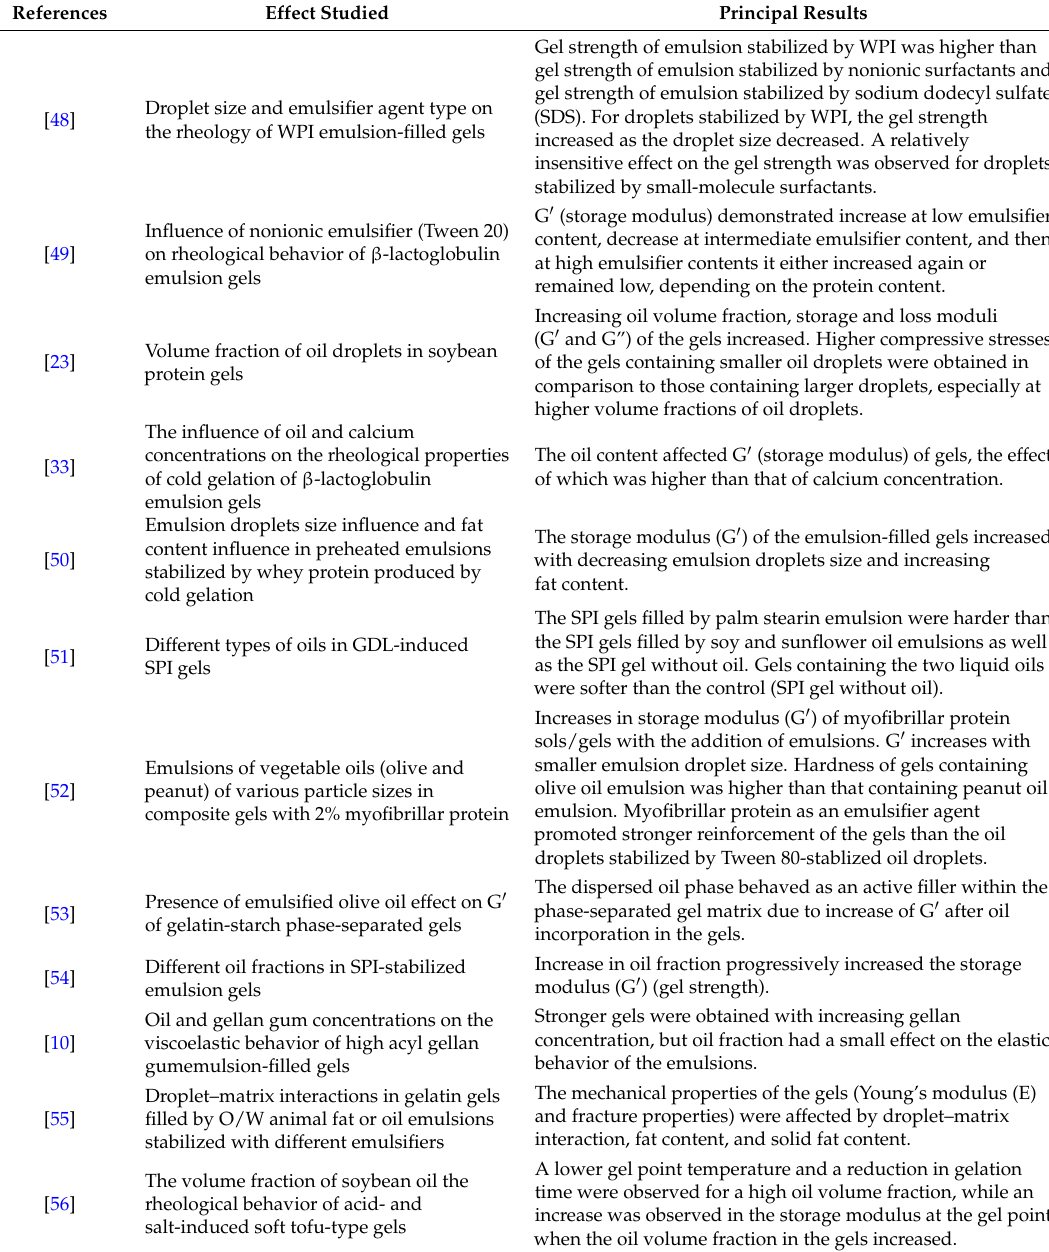
Table 1. Some interesting rheological studies on emulsion-filled gels found in the